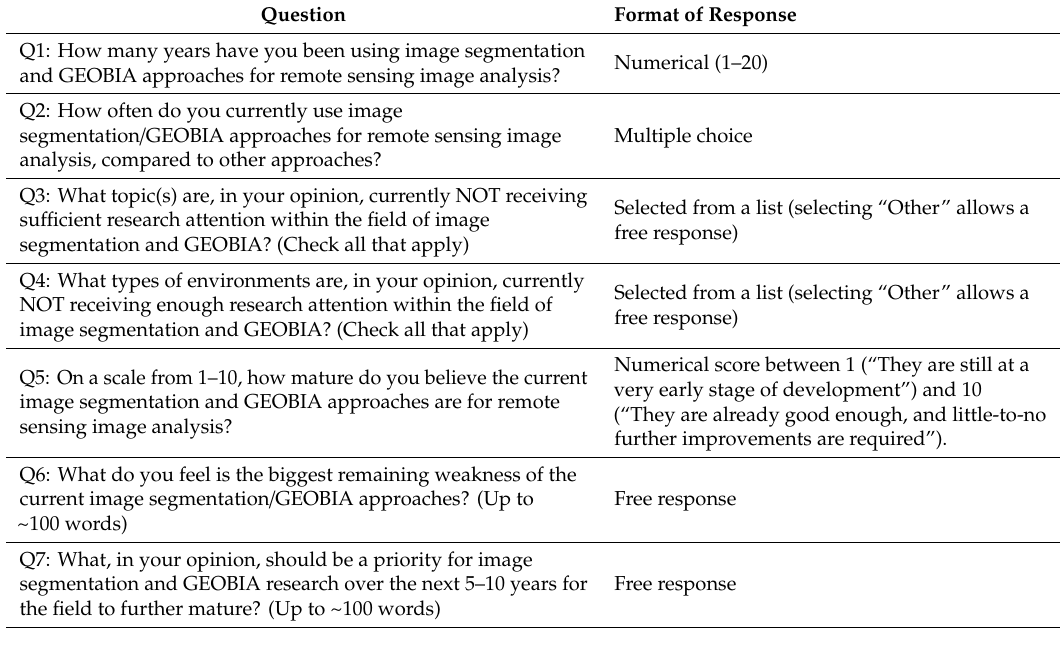
Table 2. Questions asked in online survey on image segmentation and GEOBIA.